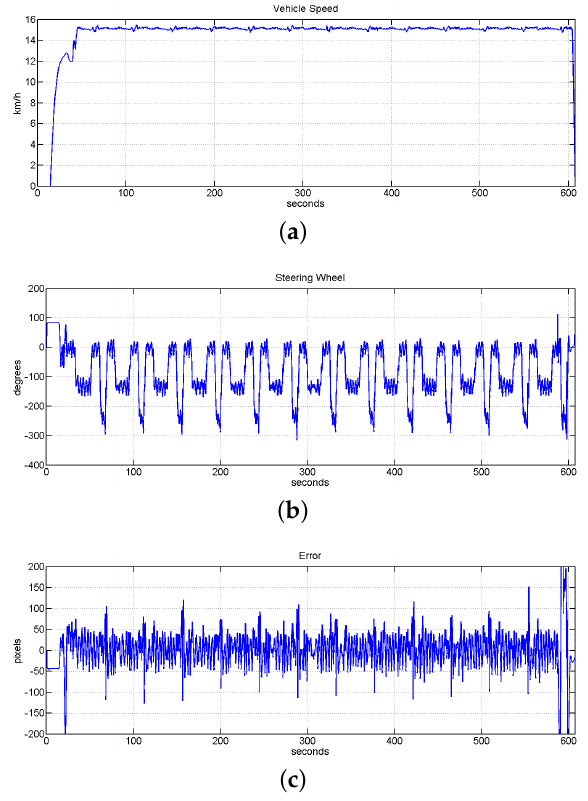
Figure 13. Evolution of the system during 13 laps inside the track with mark detection and different line occlusion onside straight line and curves. Speed was set to 15 km/h. ( a ) Vehicle speed evolution; ( b ) evolution of position of the steering wheel; ( c ) evolution of the error measured in pixels, the value of RMSE for this test is equal to 5.8098